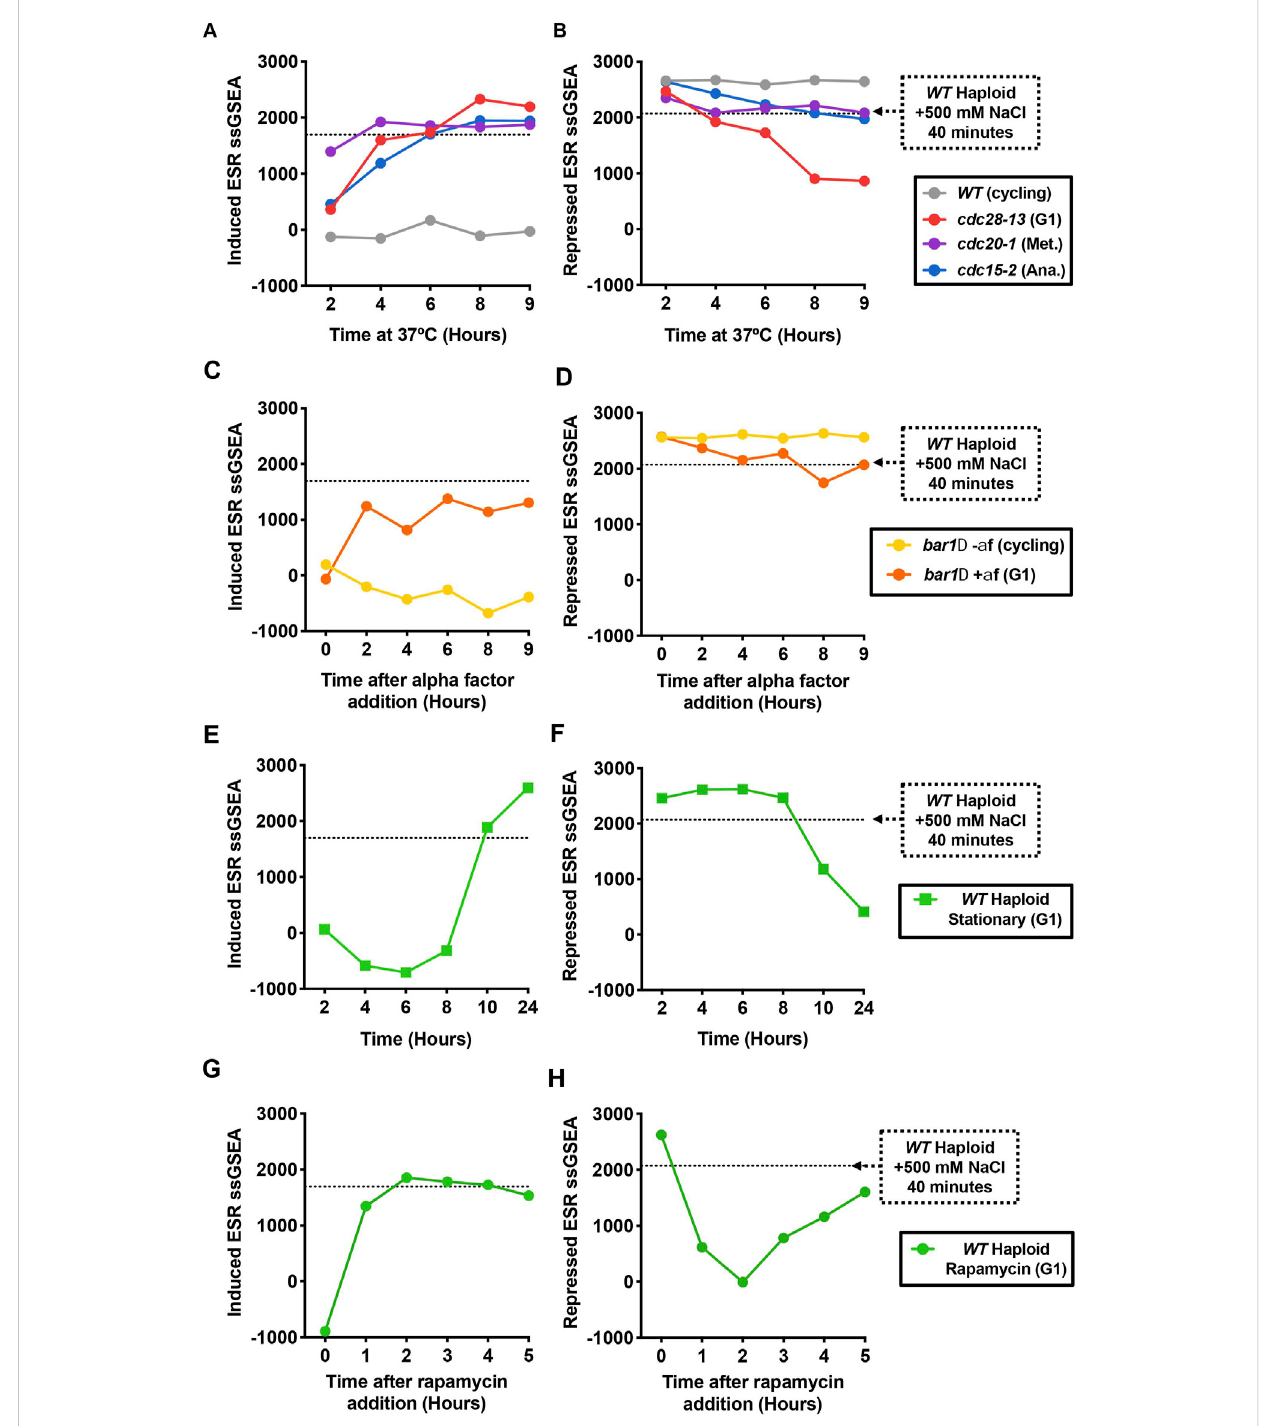
FIGURE 3 The EnvironmentalStress Response (ESR) isactivated incellcyclearrestedcells. (A, B) WT haploid (A2587), cdc28-13 (A39000),cdc20-1 (A937),and cdc15-2 (A2596) cells were grown to log phase in YEPD at 25 ° C and then shifted to 37 ° C for 9 h. WT cultures were kept in log phase, termed cycling, at OD 600nm 0.2 – 0.8, by diluting with pre-warmed (37 ° C) YEPD. RNA-Seq samples were collected, and gene expression data were analyzed by calculating ssGSEA projection values for the (A) induced ESR and (B) repressed ESR. The horizontal lines represent the induced ESR and repressed ESR ssGSEA projectionvaluesfor WT cells(A2587)treatedwith500 mMNaClfor40min,apositivecontrolforinductionoftheESR.Thesevaluesweretakenfromdata reportedin(Terhorstetal.,2020). (C,D ) SameasinA-B,butfor bar1 Δ (A2589)cellstreatedwitheitheralphafactororDMSOasdescribedinFigure2. (E,F) SameasinA-B,butfor WT haploid(A2587)cellsweregrowninYEPDfor24 hat30 ° Cwithoutdilution,reachinganOD 600nm of8.5by10 h. (G,H) Sameas in A-B, but for exponentially growing WT haploid (A2587) cells treated with 5 nM rapamycin at t 0